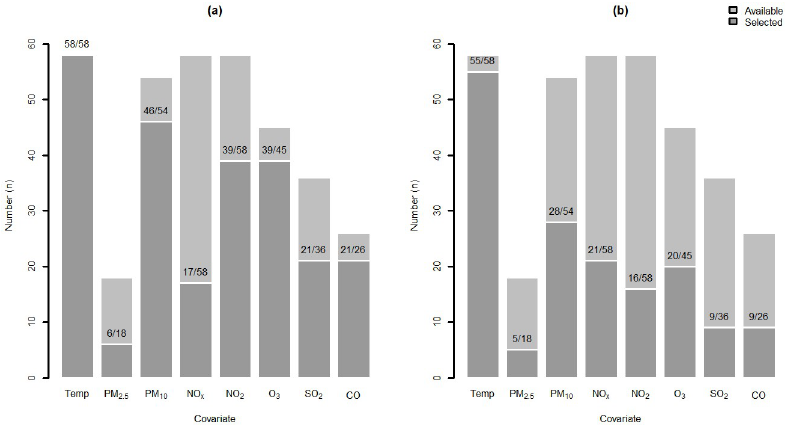
Fig 6. Barplot with the number of models with significant covariates (dark grey) out of the number of models with available covariates (light grey): (a) Reduced model M R and (b) Full model M F . The total number of spatial locations is